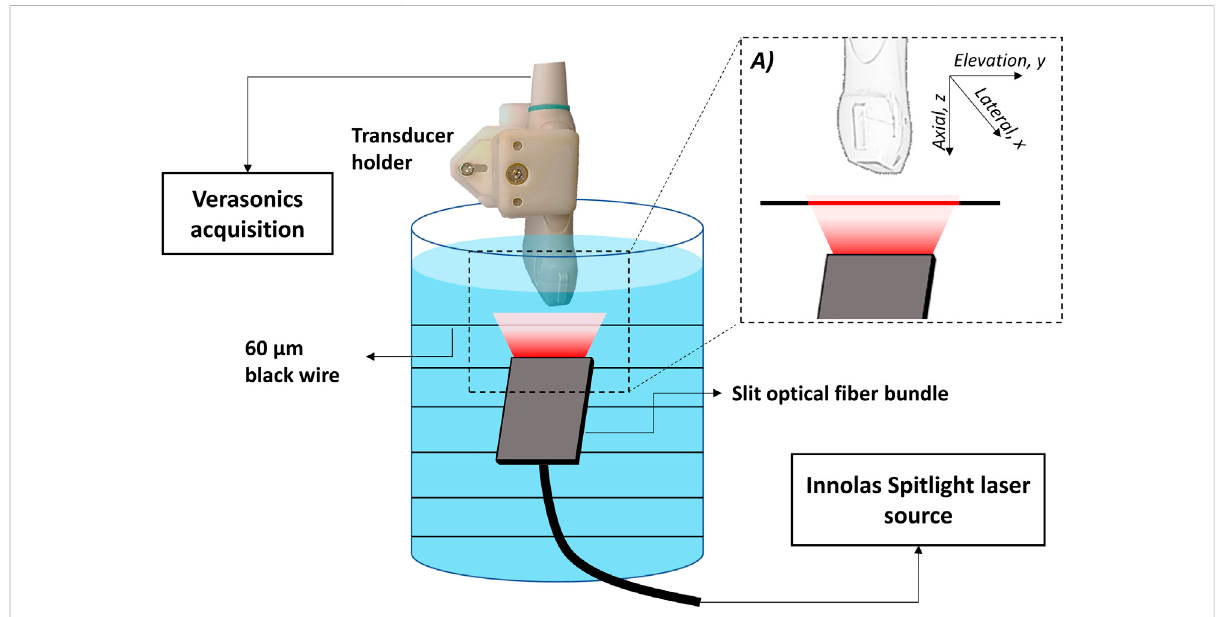
FIGURE 1 Schematic of image acquisition setup for the calibration experiment. (A) zoomed-in portion of the light illumination and detection.